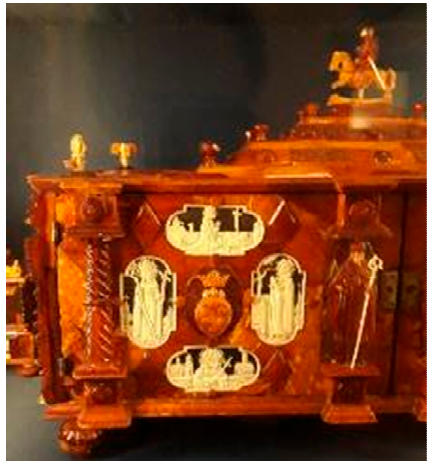
Figure 8. Danzig workshop, Reliquary of St. Kazimierz Jagiello ń czyk, c. 1677–1678 (left detail). Palazzo Pitti (Tesoro dei Granduchi), Florence. Photo by the author.